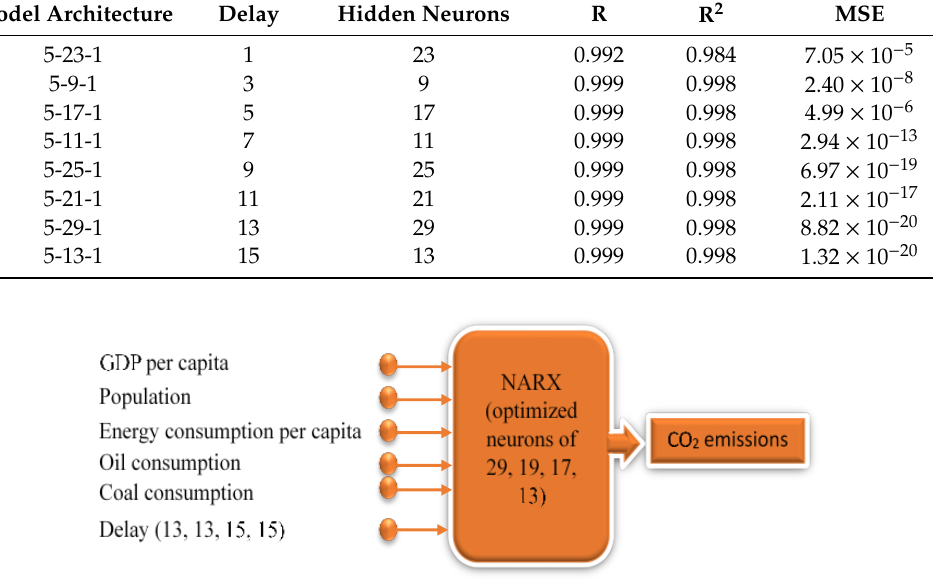
Figure 3. General representation of the optimized architecture for the NARX model used for prediction of CO 2 emissions in Malaysia, Thailand, Indonesia, and Philippines. Table 6. Details of the optimized NARX architecture used for the modeling.